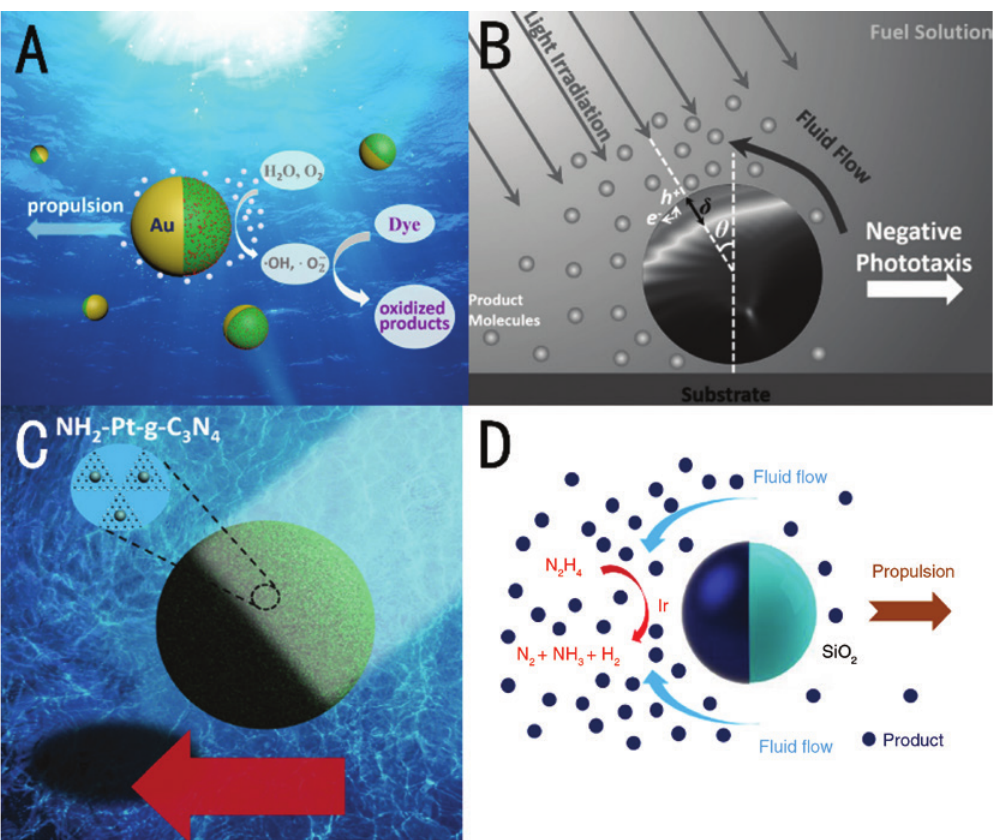
Janus micromotor based on colloidal Figure 6: Light-driven micro/nanomotors with osmotic propulsion. (A) A novel light-driven Au-WO 3 carbon WO nanoparticle composite spheres, which displays efficient propulsion in pure water activated by UV light [43]. Copyright 2017, 3 American Chemical Society. (B) Phototaxis of isotropic TiO micromotor due to oxygen molecules’ gradient as a result of asymmetrical 2 chemical reaction under UV irradiation [78]. Copyright 2016, Wiley-VCH. (C) Schematic illustrating the self-assembly effect of nanomotors due to osmosis under light irradiation [80]. Copyright 2017, The Royal Society of Chemistry. (D) Schematic of the Ir/SiO Janus micromotors 2 propelled by osmosis due to N , H and NH molecules’ concentration gradient generated around the micromotors [79]. Copyright 2014, 2 2 3 American Chemical